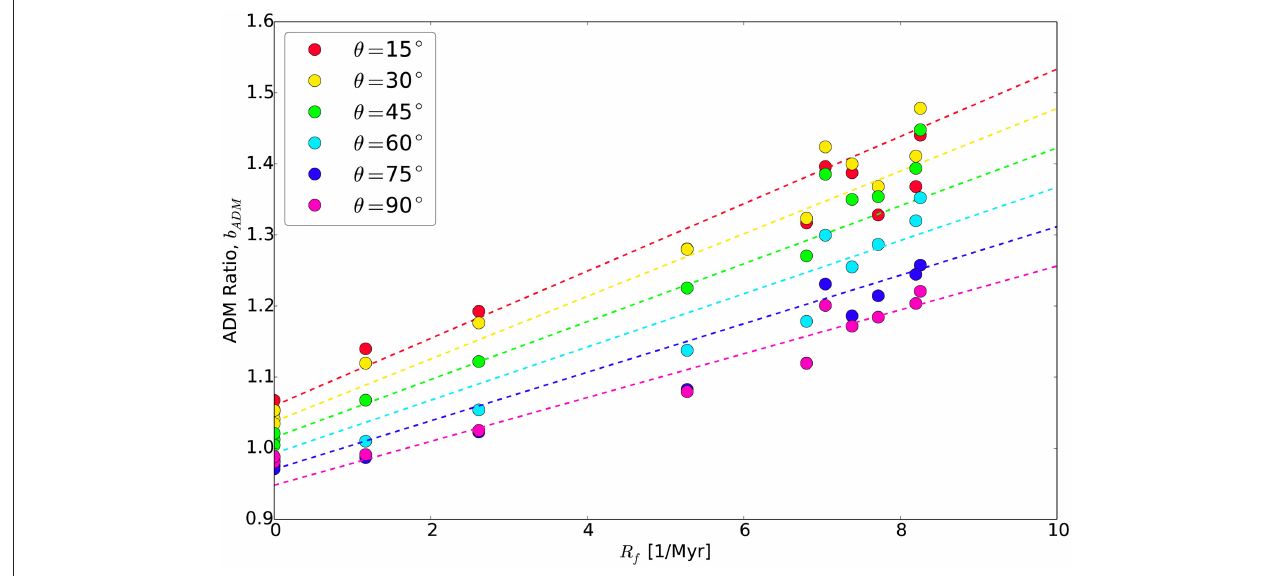
FIGURE 11 | Dipole moment bias b ADM from (20). Colors refer to site co-latitude (see legend). Dashed lines are from bilinear fit in (24).